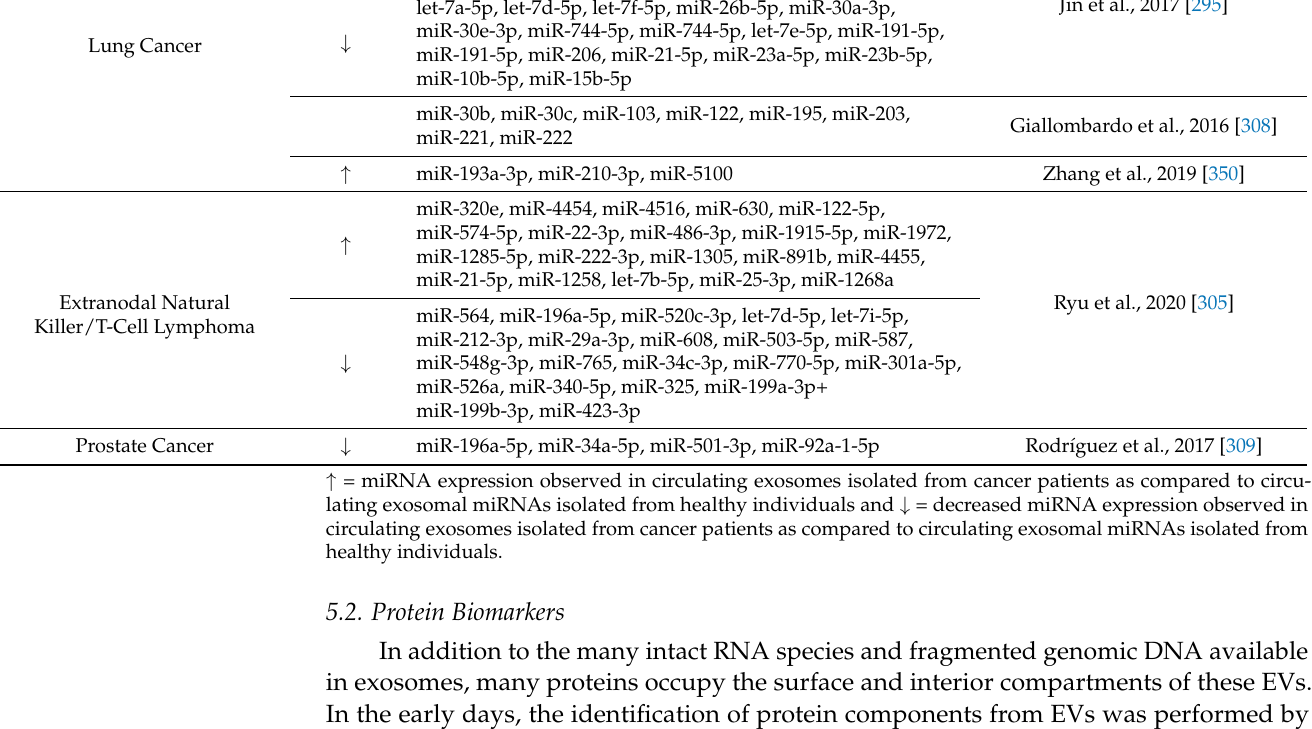
↑ = miRNA expression observed in circulating exosomes isolated from cancer patients as compared to circu- lating exosomal miRNAs isolated from healthy individuals and ↓ = decreased miRNA expression observed in circulating exosomes isolated from cancer patients as compared to circulating exosomal miRNAs isolated from healthy